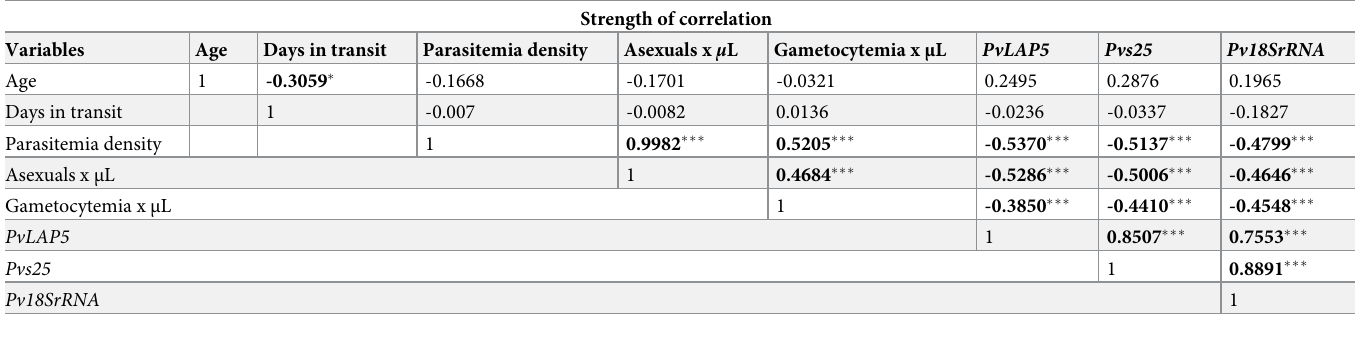
Table 3. Multivariate analysis of Plasmodium vivax field